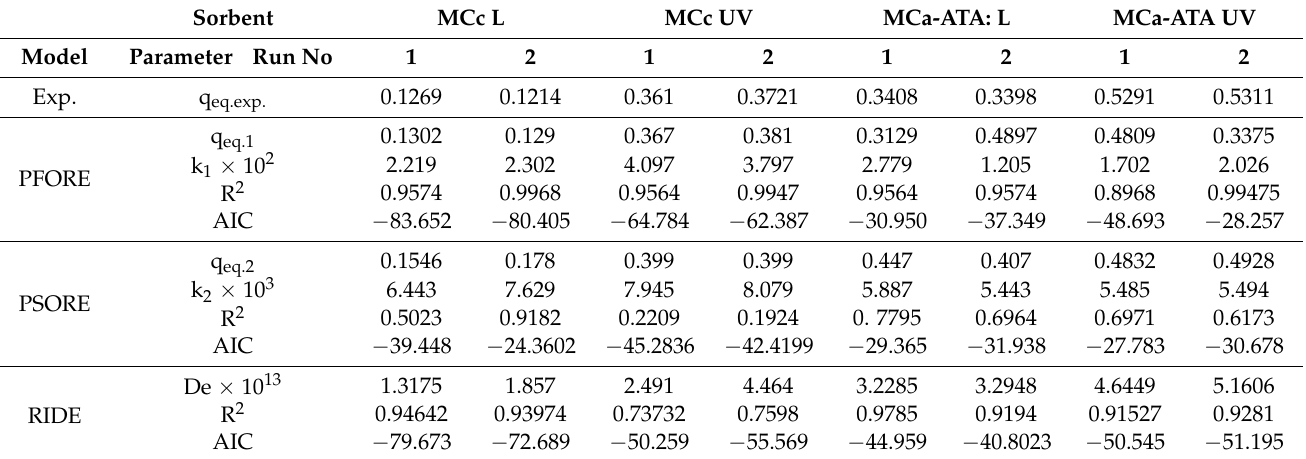
Table 2. Parameters of the uptake kinetics for MCc and MCa-ATA in visible light (L) and UV effect.